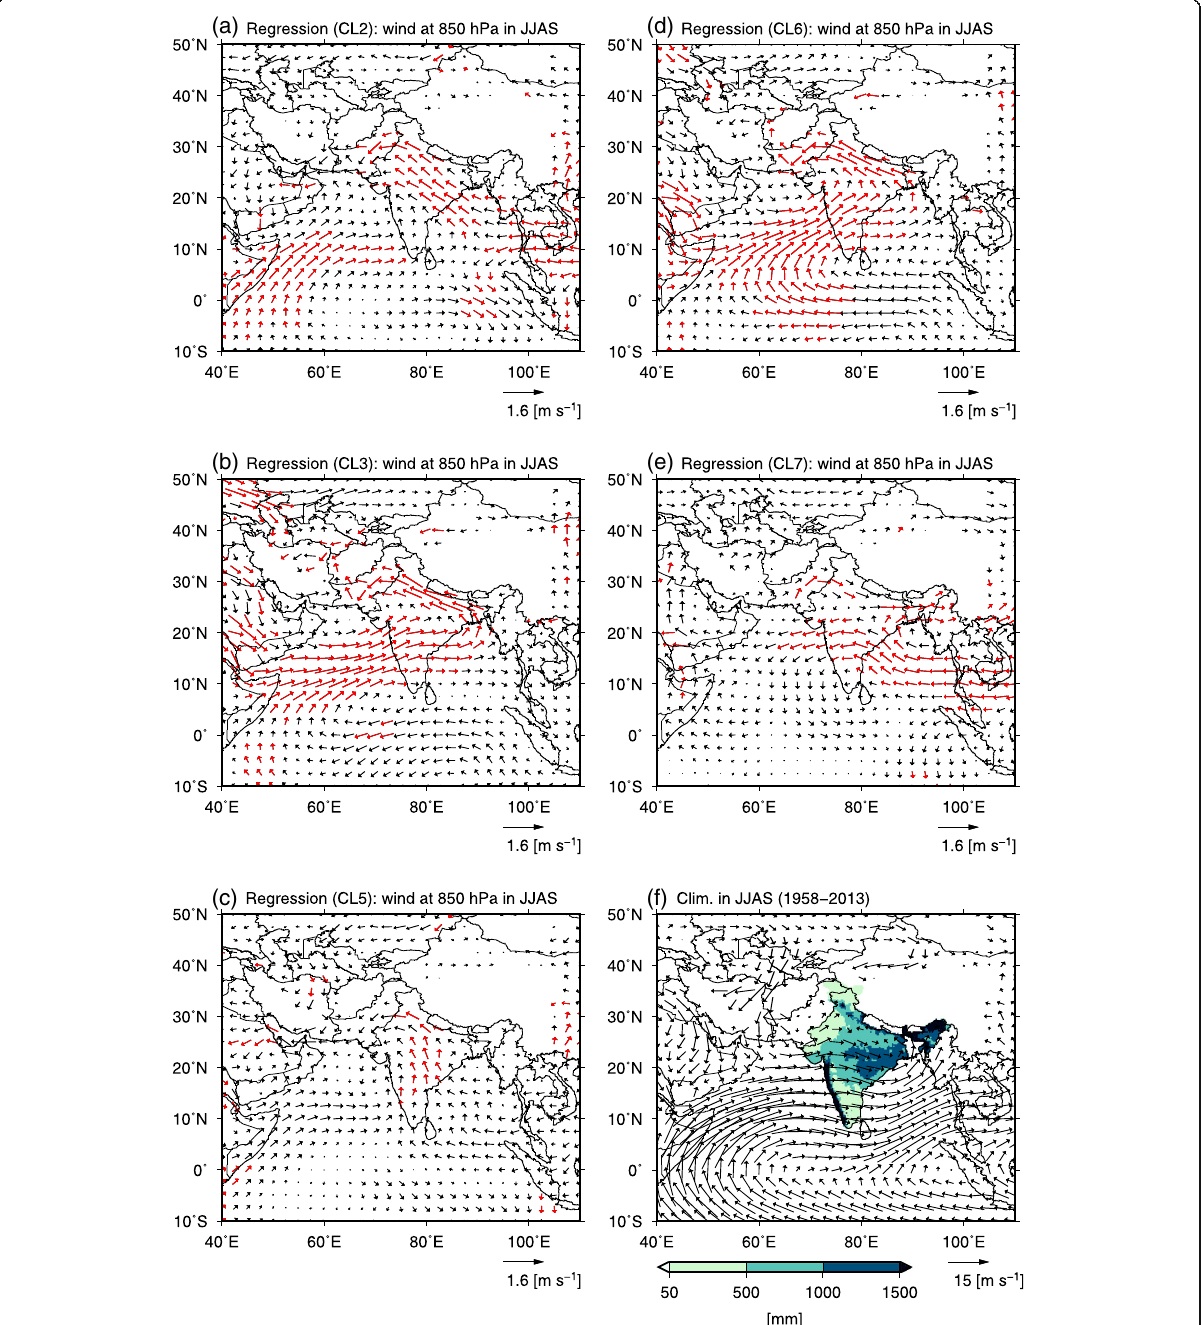
Fig. 7 Regression coefficient of rainfall and wind for the summer monsoon season. The regression coefficient (objective variable is precipitation) between interannual variation of rainfall and the wind field at 850 hPa (m s − 1 ) (vector) for each cluster ( a ) – ( e ), and the distribution of the climatological values (averaged for 1958 – 2013) of seasonal precipitation and wind vectors at 850 hPa, as in Fig. 6b ( f ). Colored (red) vector shows significance over the 2% level based on the Student t